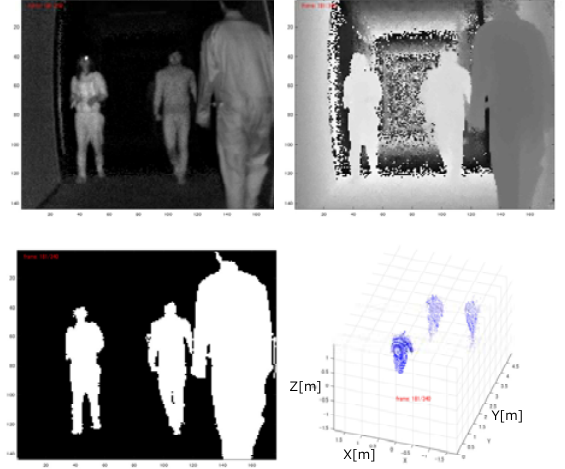
Figure 10. Pedestrian extraction result (left top: intensity image, right top: depth image, left bottom: segment image, right bottom: point